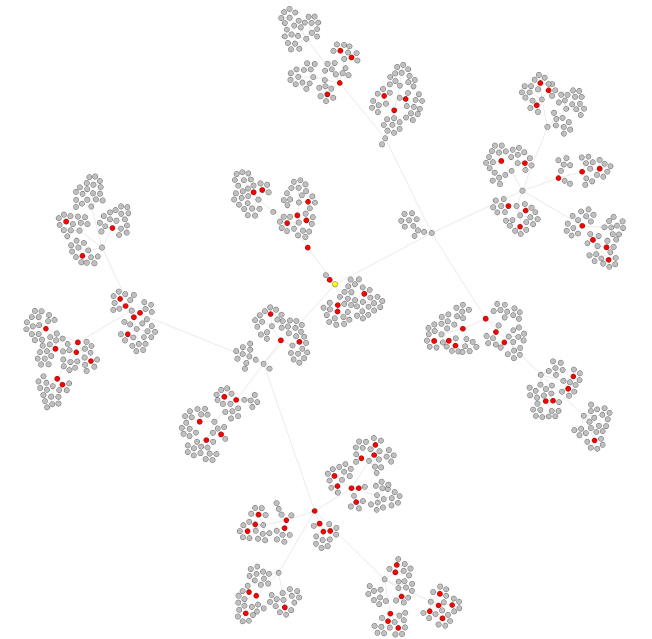
Figure 5. Ten percent of the nodes are selected as undetected nodes that are marked by red. They will be removed from the network.